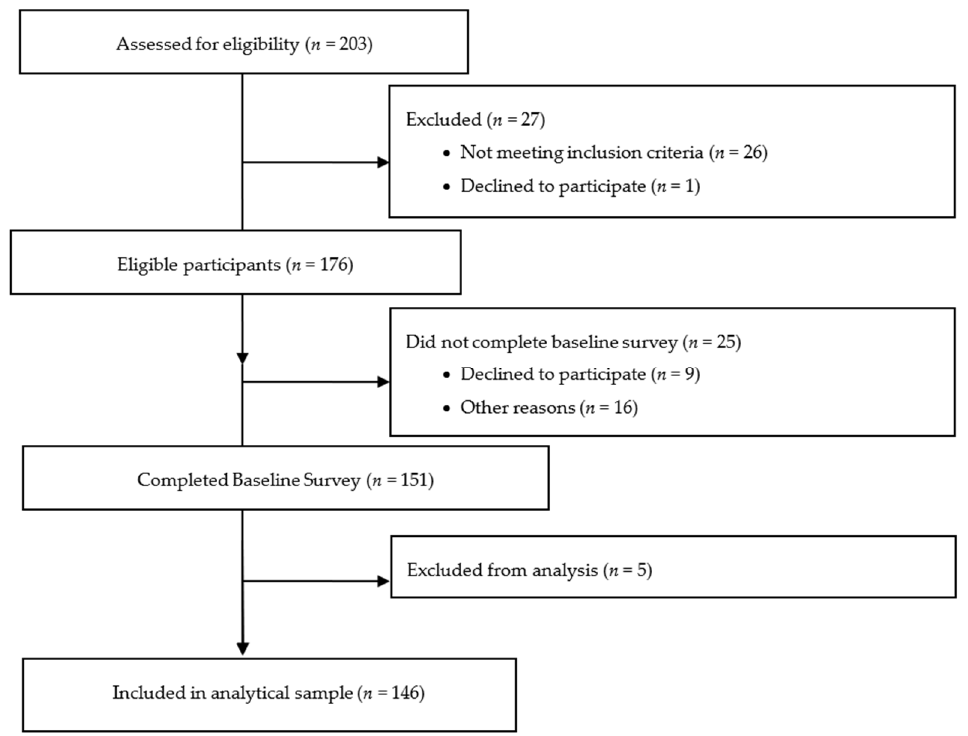
Figure 1. Diagram showing the number of participants screened for eligibility, determined to be eligible, and enrolled as of 26 July 2021. eligible, and enrolled as of 26 July